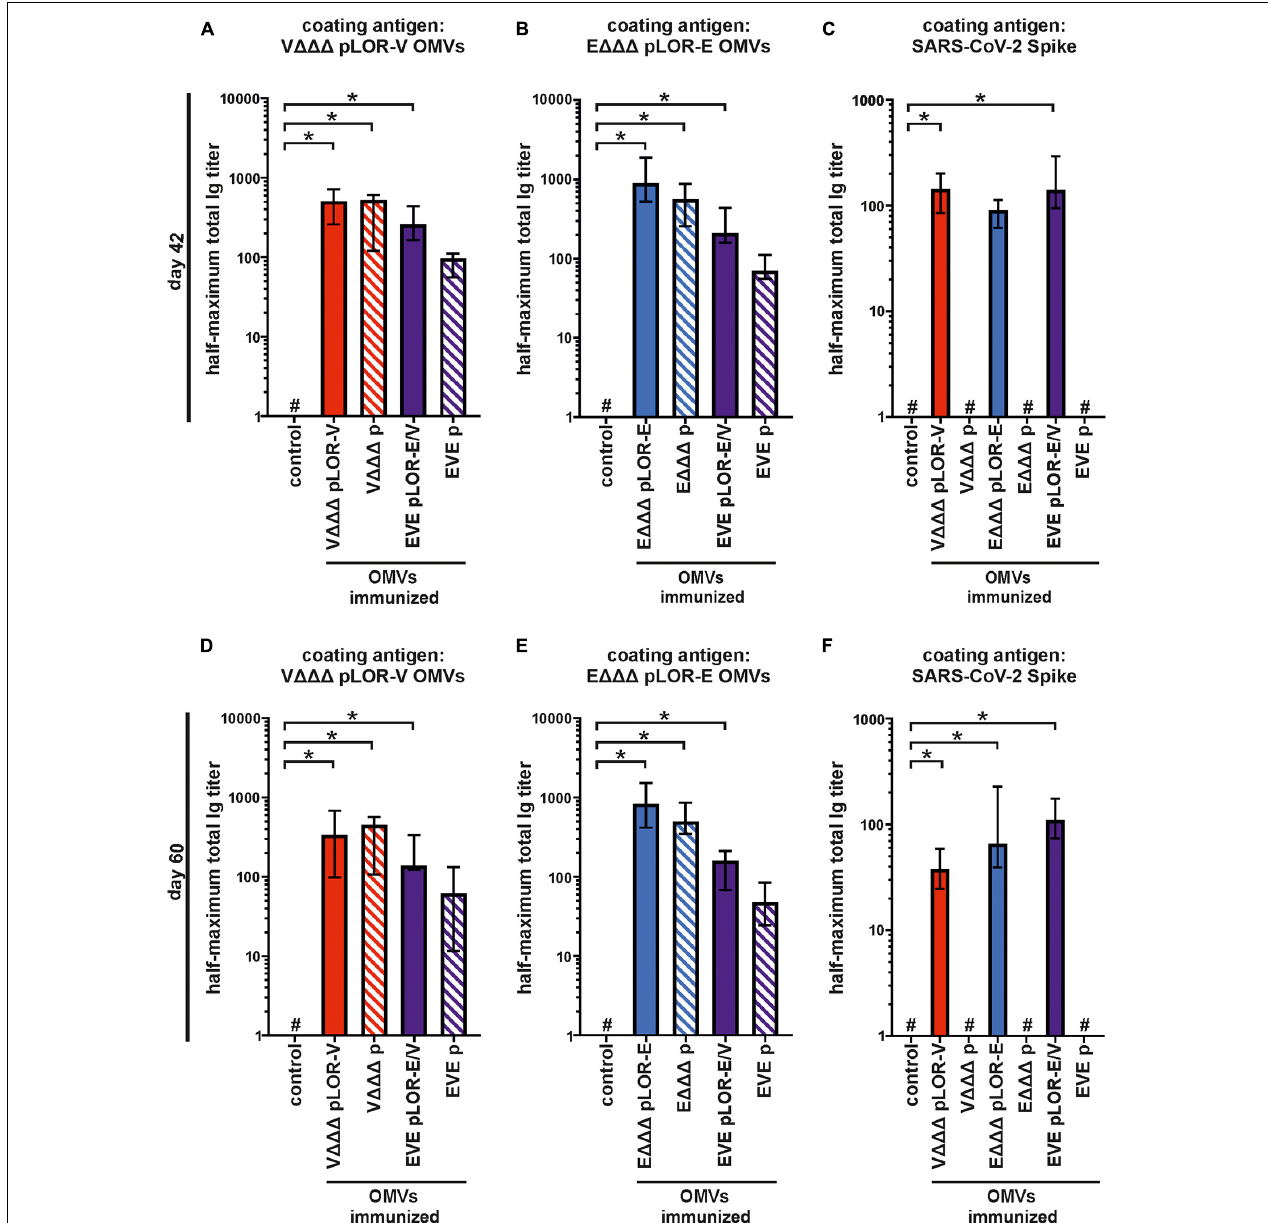
FIGURE 5 | Quantification of the total immune response against V. cholerae , ETEC and SARS-CoV-2 Spike protein induced in OMV-immunized mice. Shown are median half-maximum total Ig titers to OMVs derived from V (cid:49)(cid:49)(cid:49) pLOR-V (A,D) and E (cid:49)(cid:49)(cid:49) pLOR-E (B,E) as well as to SARS-CoV-2 Spike protein (C,F) in sera collected at day 42 (A–C) or day 60 (D–F) from mice of the respective immunization groups as indicated ( n = 7 for each group). The error bars indicate the interquartile range of each data set and the hash key that the result of the data set was below the limit of detection, which was set to 1. Significant differences to the sham-immunized control group are marked by asterisks ( p < 0.05; Kruskal–Wallis test and post hoc Dunn’s multiple